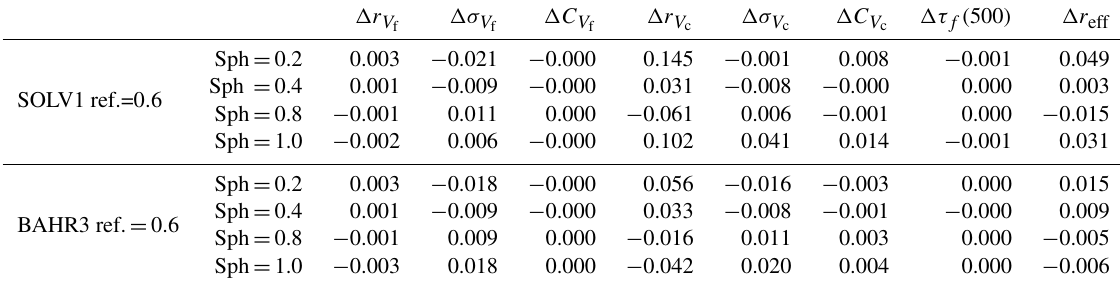
Table 12. Sphericity tests results. Differences between GRASP-AOD code with modified sphericity parameters and GRASP-AOD code with reference sphericity value of 0.6. The first six columns depict the bimodal log-normal size distribution parameters: volume median radius ( r V , r V [µm]), geometric standard deviation ( σ V c f the fine-mode aerosol optical depth at 500nm ( τ f ( 500 ) ) and the effective radius ( r eff [µm]).